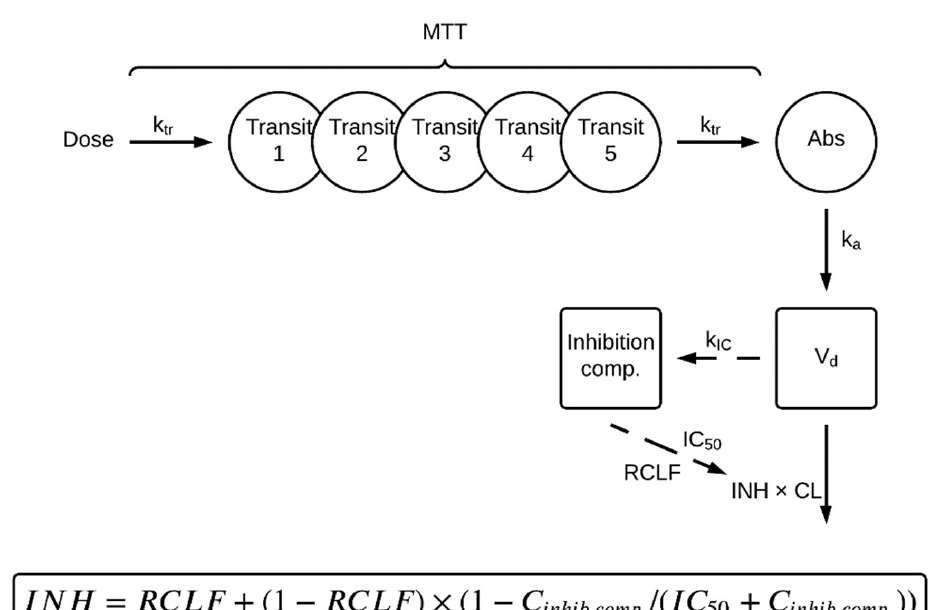
Figure 1. Schematic representation of the final linezolid population pharmacokinetic model. First, the dose is transferred into an absorption compartment (Abs) via five transit compartments (Transit